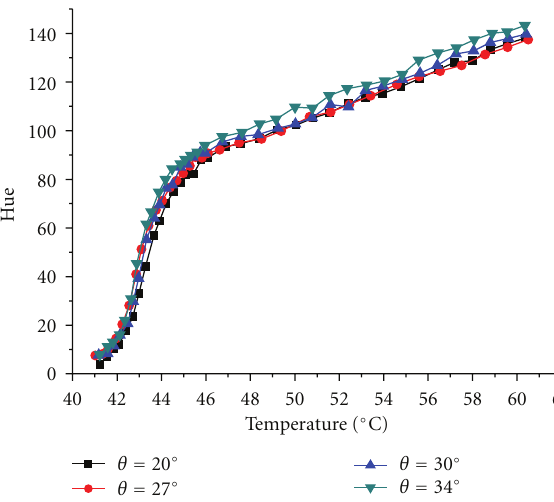
Figure 2: The raw hue and the median filtered hue calibrations of the TLC.